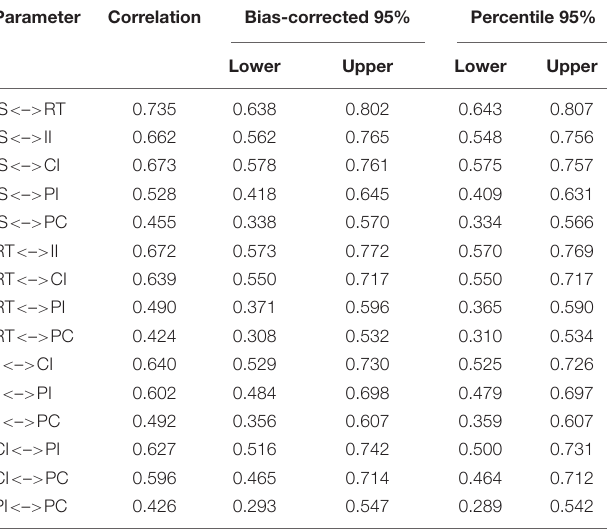
TABLE 2 | Confirmatory factor analysis. TABLE 3 | Discriminant validity for the measurement model.